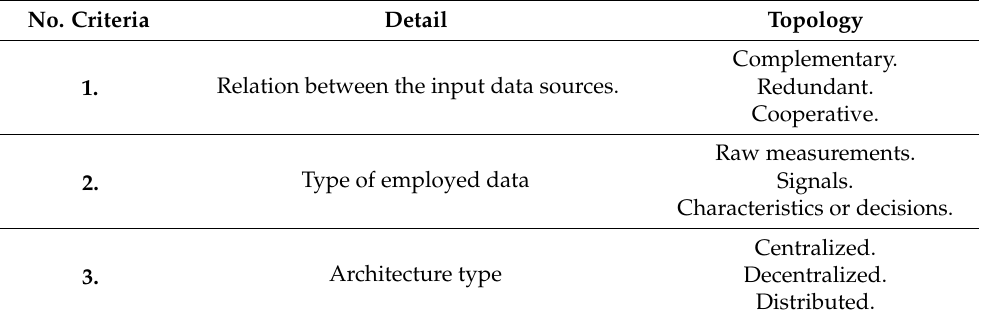
Table 2. Main Data fusion methods and techniques classification.